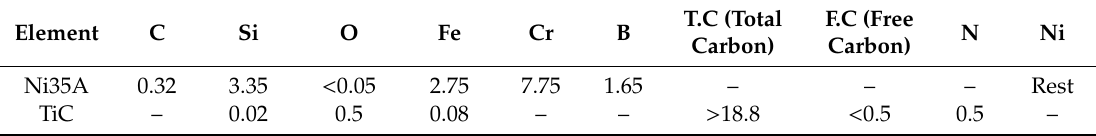
Table 1. Chemical components of Ni35A and TiC particle